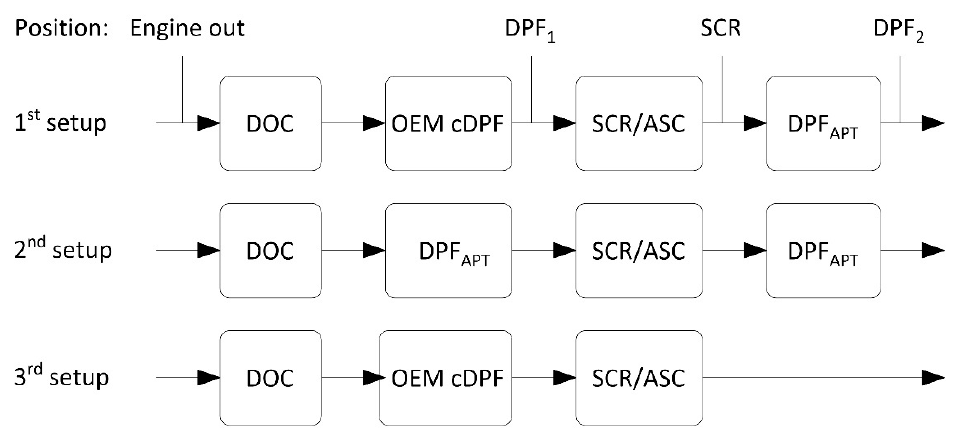
Figure 1. Layout of the aftertreatment configurations tested. APT = Accelerated Purification Tech- nology; ASC = Ammonia Slip Catalyst; cDPF = Catalyzed Diesel Particulate Filter; DOC = Diesel Oxidation Catalyst; DPF = Diesel Particulate Filter; OEM = Original Equipment Manufacturer; SCR = Selective Catalytic Reduction.